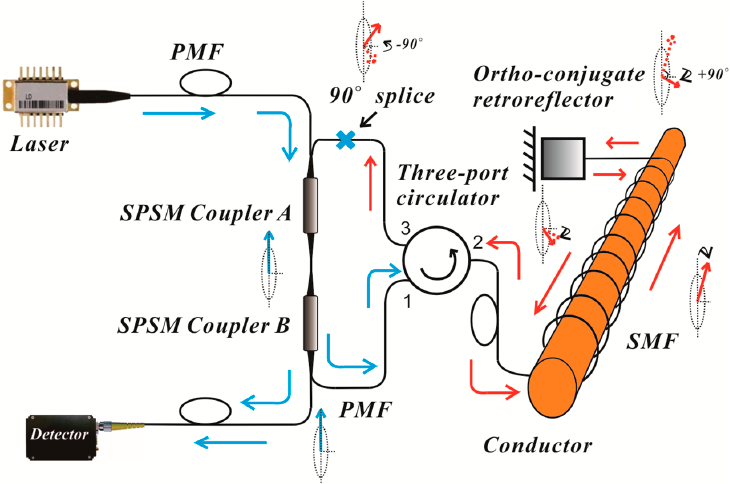
Figure 1. The configuration of the loop AFCS based on SPSM couplers.